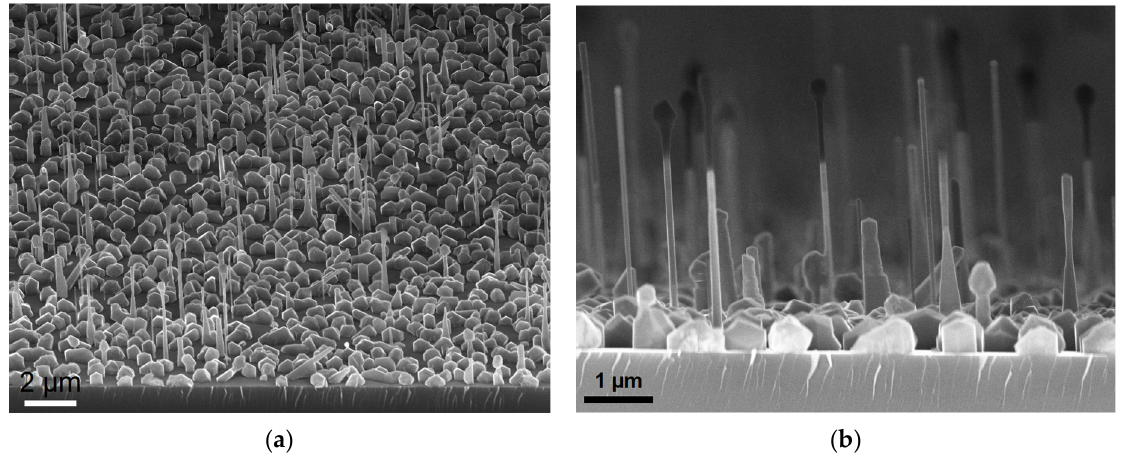
Figure 2. SEM images of a representative as-grown GaPAs/GaP NW light-emitting diode (LED) array in a 45° ( a ) and side view ( b